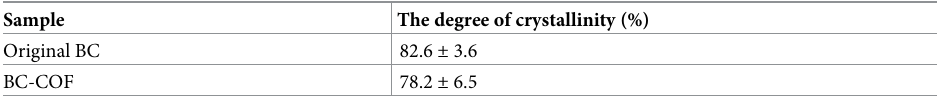
Table 2. The degree of crystallinity (%) of original BC and BC-COF bio-leather (Extraction conditions: Liquor ratio of 1:10 (w/v), coffee at an amount of 200 wt% BC, 90˚C, 1 h; dyeing conditions: Fabric-to-liquor ratio of